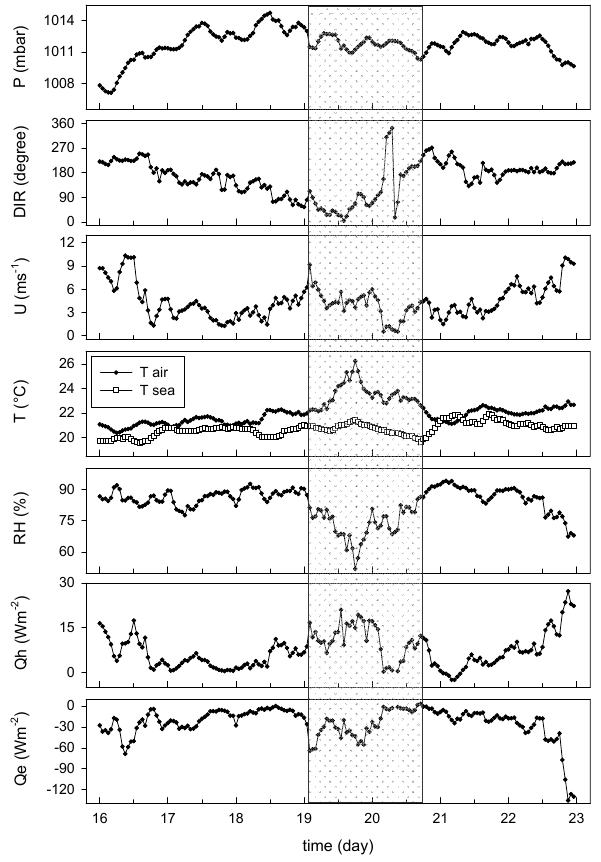
Fig. 3. From top to bottom, time series of the surface pressure P , wind direction DIR, wind speed U , air temperature T a and sea tem- perature T s (in the same plot), relative humidity RH, Sensible heat flux Q h and latent heat flux Q e during LASIE. Note that positive values indicate downward fluxes. The shaded area corresponds to offshore flow that causes an increase of air temperature and the evo- lution of the vertical structure of the Marine Boundary Layer in Fig.